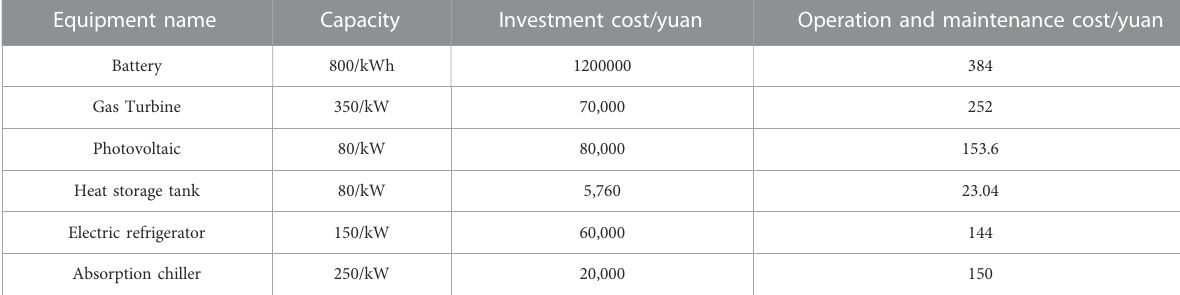
TABLE 3 Optimization results of the building microgrid system under Case